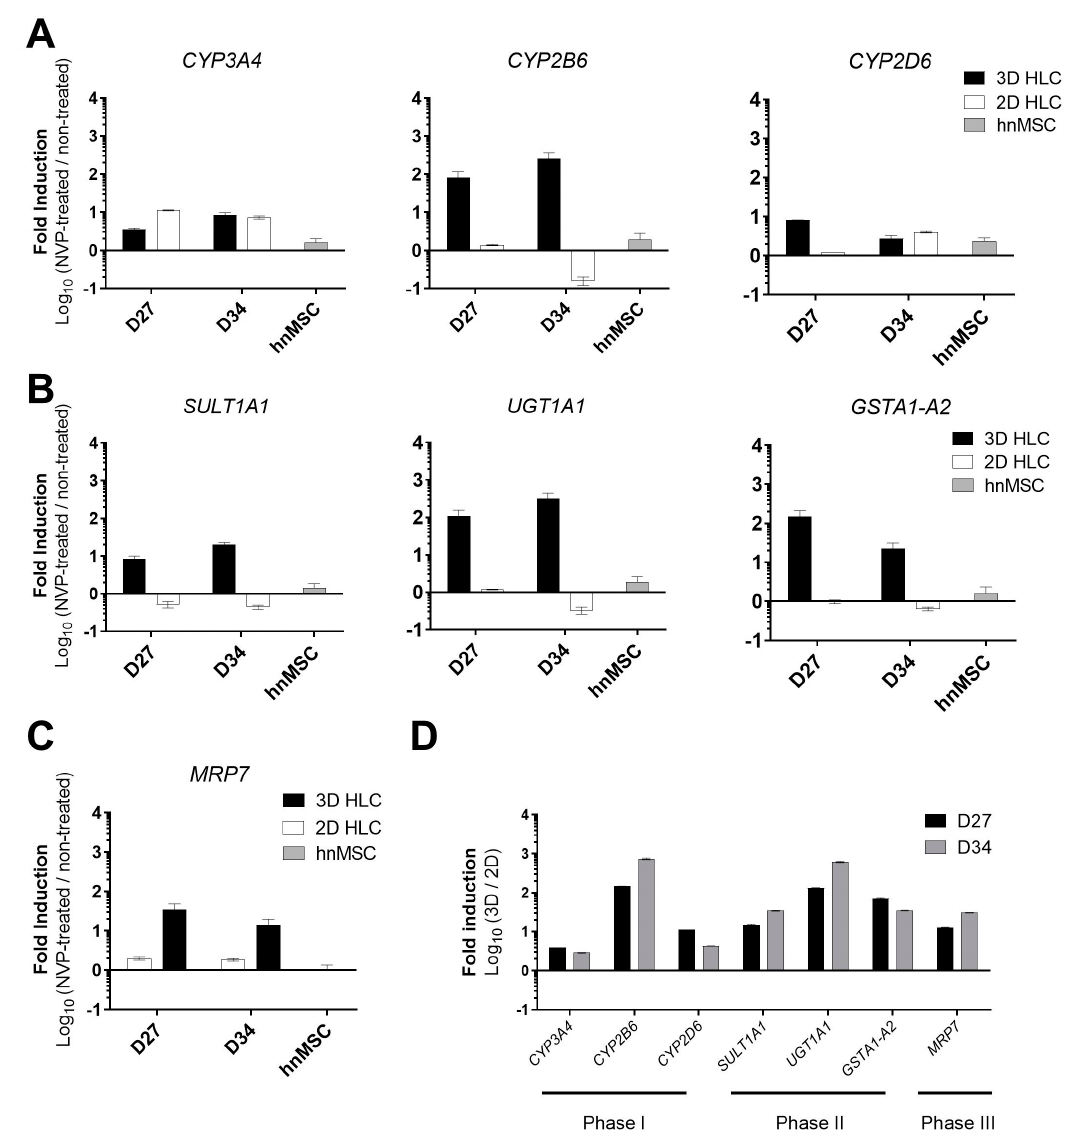
Figure 2. Gene expression analyses of Phase I, II and III related genes of 3D- and 2D-HLCs after 3 (D27) and 10 days (D34) of NVP treatment. ( A ) Gene expression of Phase I enzymes comprising CYP3A4 , CYP2B6 and CYP2D6 in NVP-treated cells relative to non-treated cells. ( B ) Gene expression of Phase II enzymes comprising SULT1A1 , UGT1A1 and GSTA1-A2 in NVP-treated cells relative to non-treated cells. ( C ) Gene expression of the MRP7 transporter in NVP-treated cells relative to non-treated cells. ( A – C ) Data for hnMSC exposed to NVP for 3 days and used as negative controls, are also shown. ( D ) Phase I, II and III gene expression in 3D-HLCs relative to 2D-HLCs in NVP-treated cells at D27 and D34. The data (Mean ± SD, n = 3) are normalized to the reference gene β -ACTIN and expressed as the log 10 of the ratios.